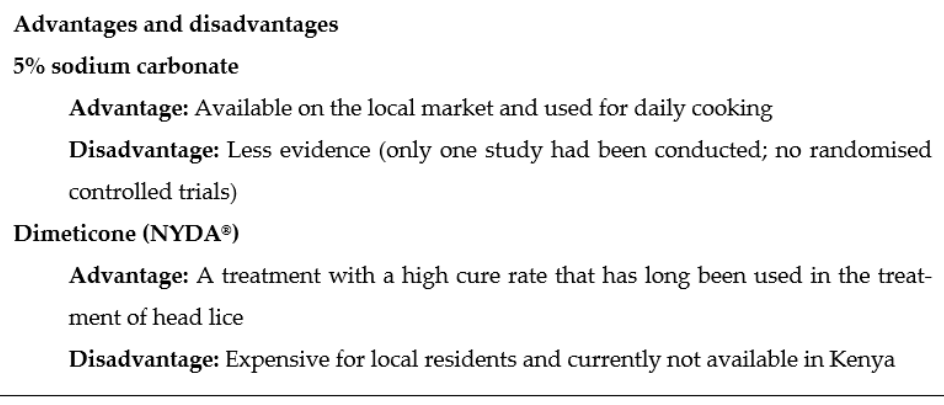
Figure 2. Advantages and disadvantages of the treatments.